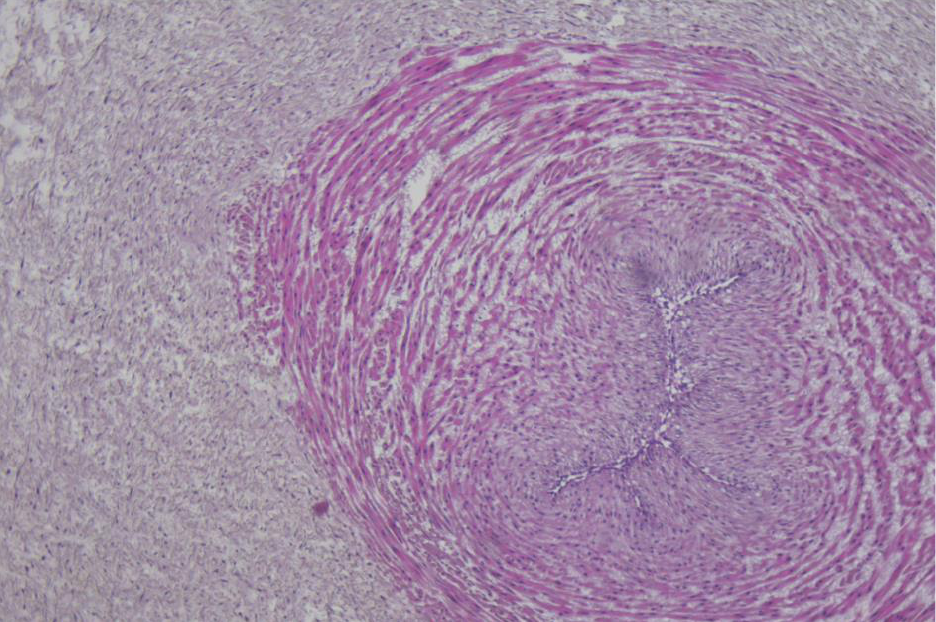
Figure 2. Histological aspect of umbilical cord section, lacking inflammatory reactions, H&E stain, ×100 magnification.